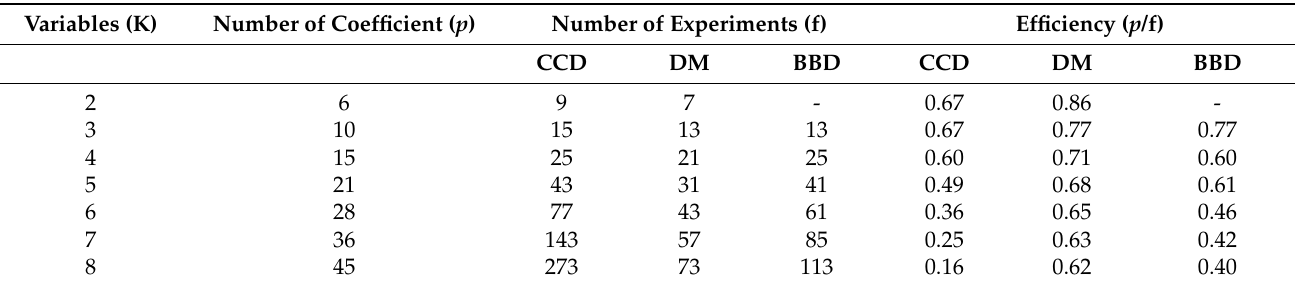
Table 7. Efficiency of various DoE